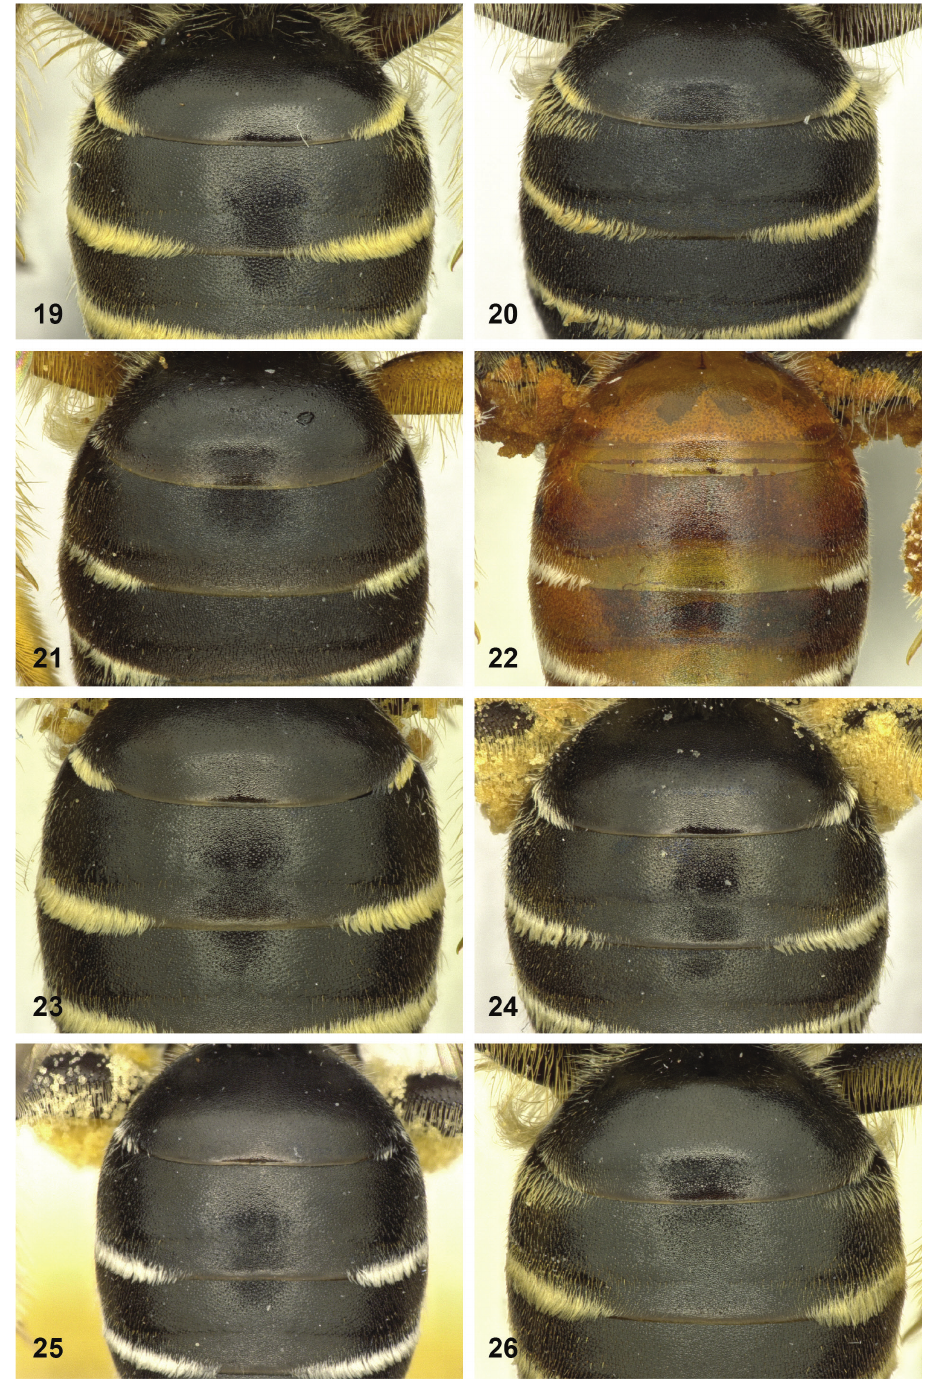
Figures 19–26. Metasomal terga 1–3 of females of Taeniandrena 19 Andrena afzeliella 20 A.